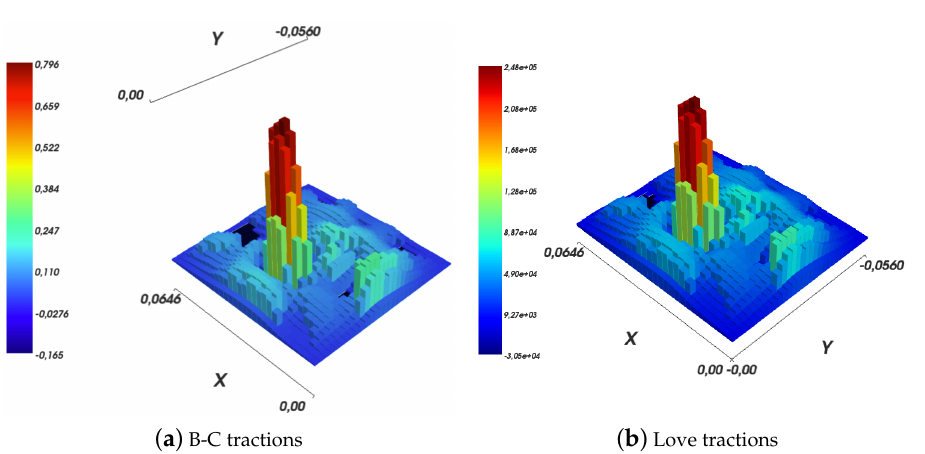
Figure 12. Solutions to a square inverse elastic problem, as given by Boussinesq–Cerruti’s and Love’s